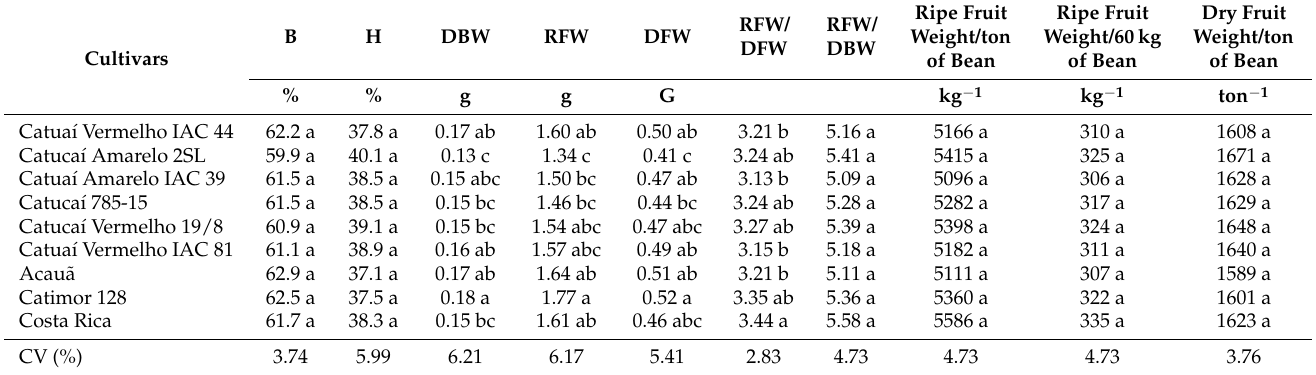
Table 5. Characteristics of ripe and dried fruit and coffee bean in nine Coffea arabica cultivars,